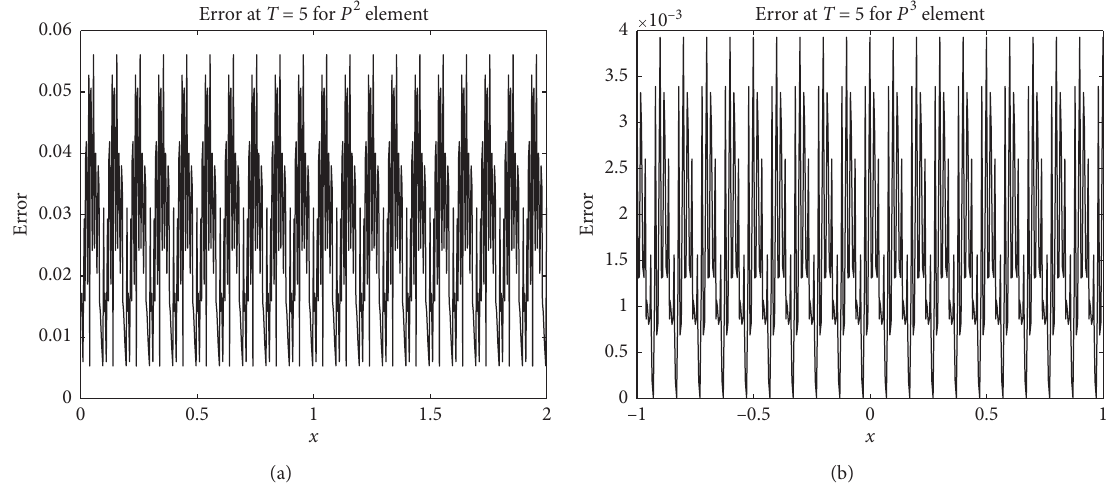
Figure 2: The error ‖ w ( x, t ) − w